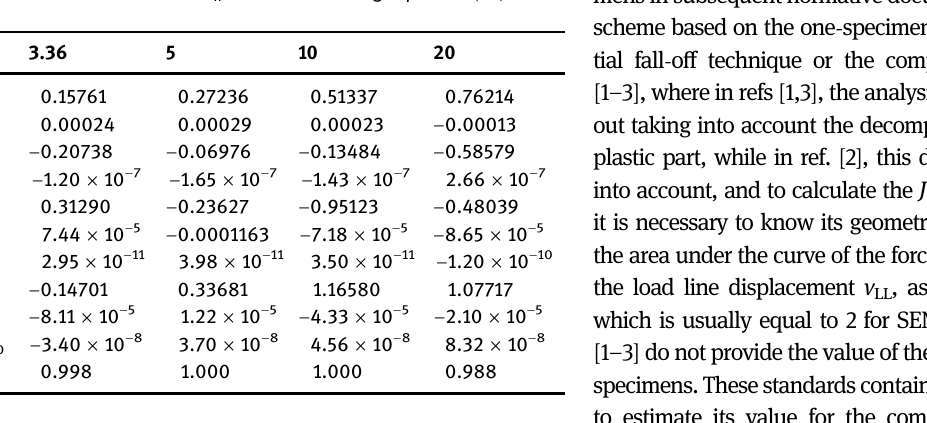
Table 7: Values of the approximation coe ffi cients D 1 – D 10 allowing to estimate the value of the d n coe ffi cients using equation ( 18